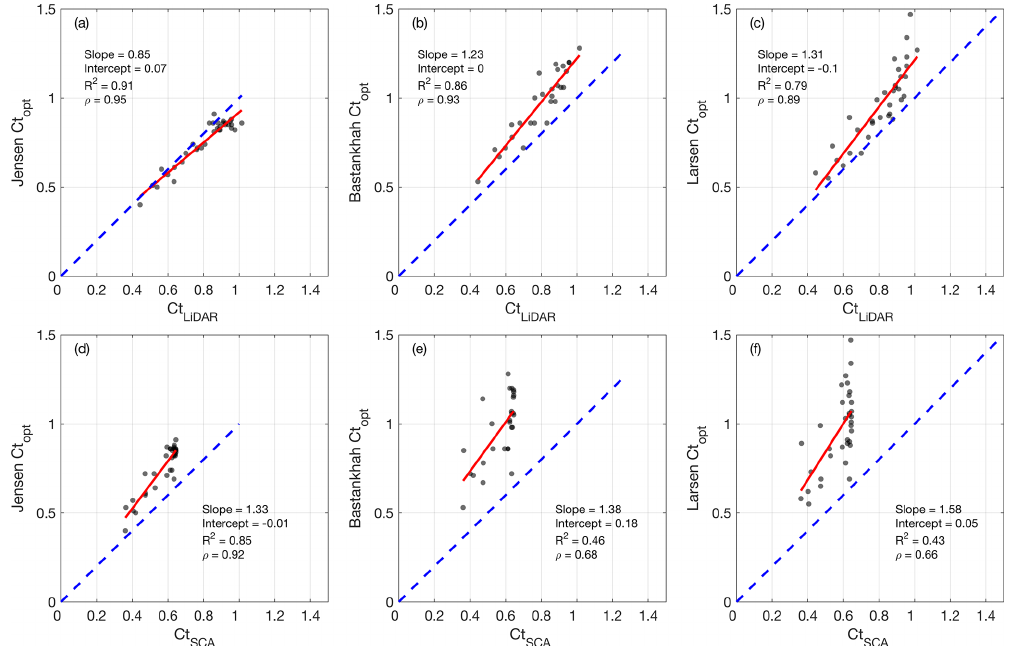
, against that calculated opt